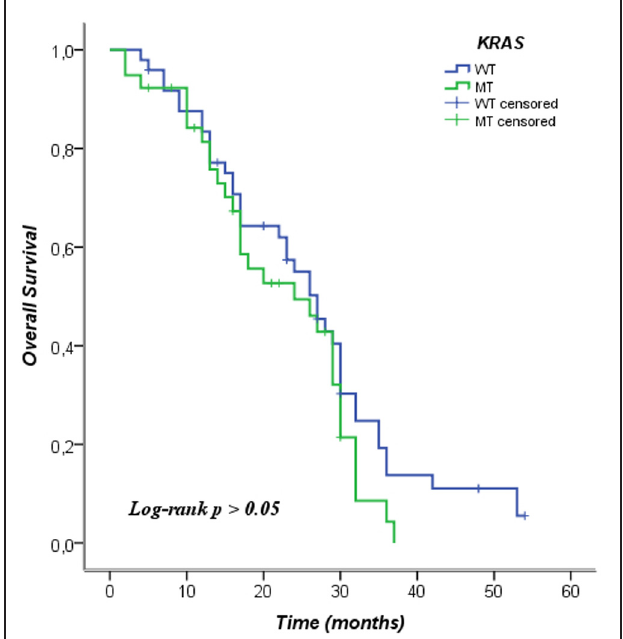
FIGURE 2 | Kaplan–Meier curve of overall survival according to mutation status of KRAS . WT, wild type; MT, mutated.